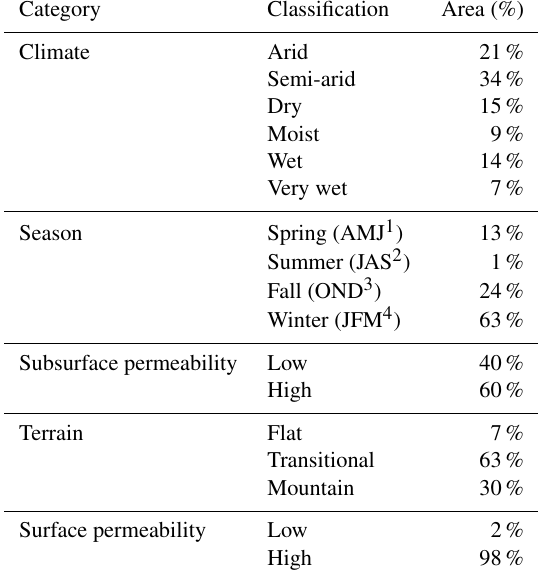
Table 3. Percent of area of each HL category and classification within the six-state region (1971–2000).